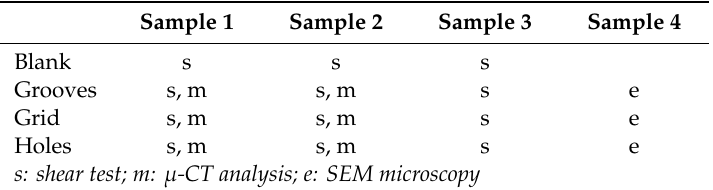
Table 1. Experimental plan for four samples of each type of surface structure.